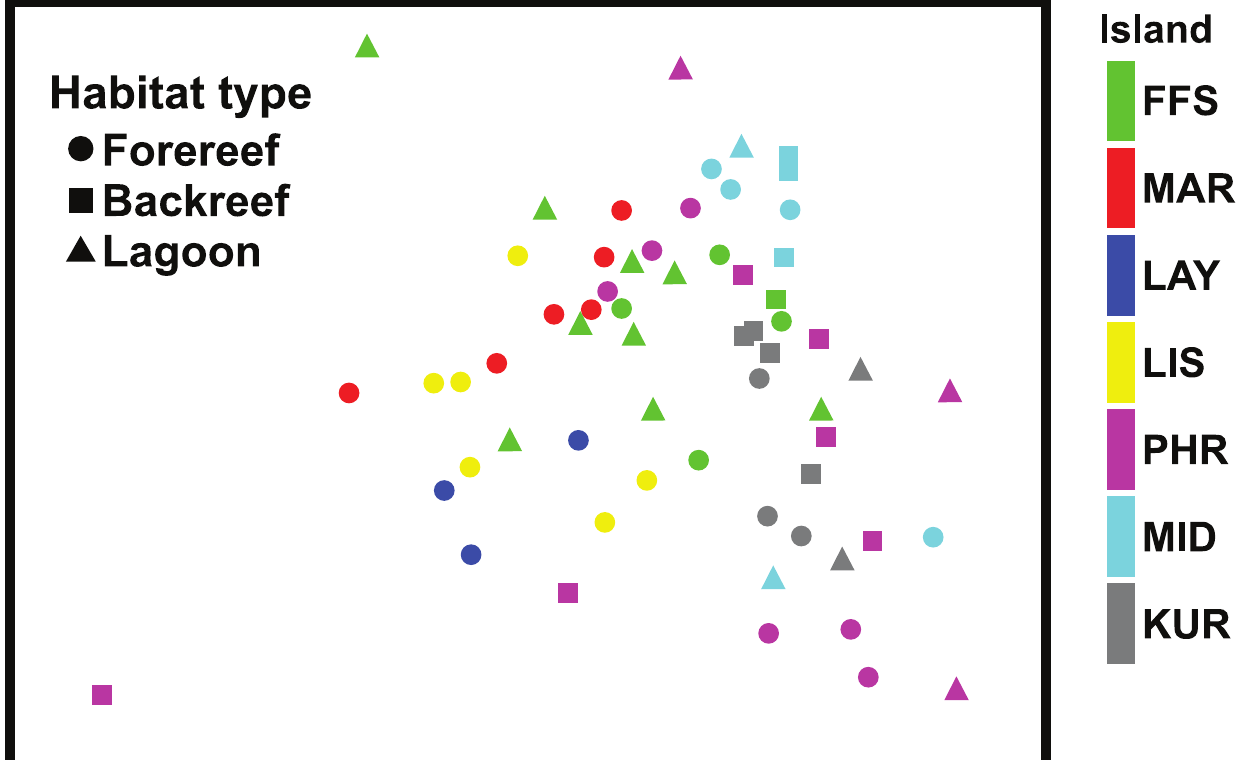
Figure 3. nMDS ordination depicting relationship of sites surveyed. Relationships are based on percent cover of benthic organisms (2D stress=0.19). Tick marks on the x-axis visually separate data from each island.